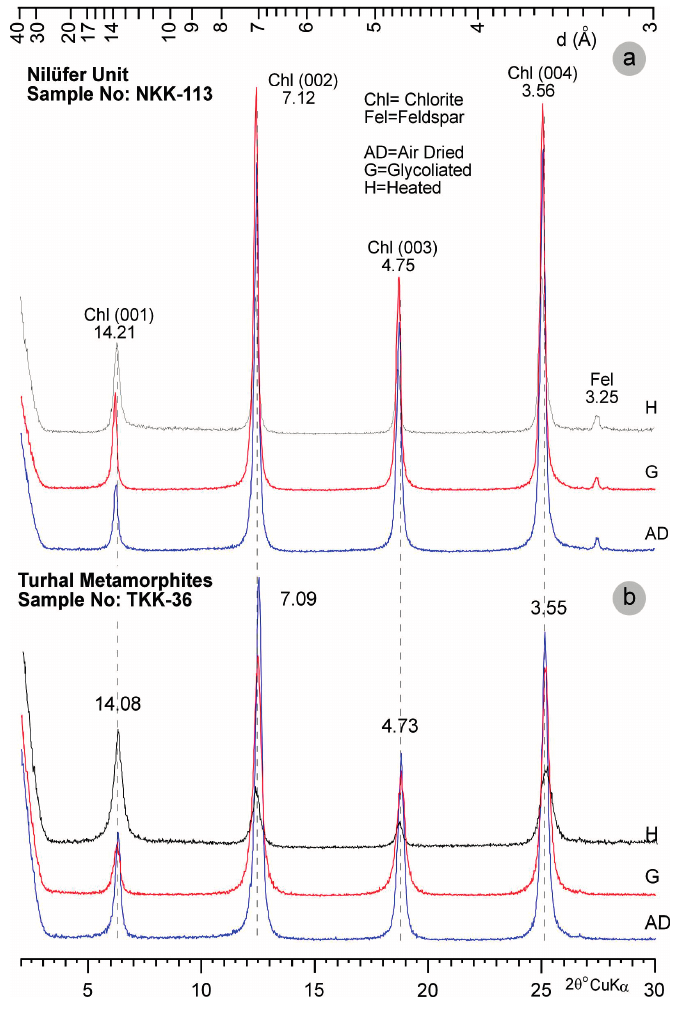
Figure 5. Oriented X-ray diffraction (XRD) patterns of chlorite minerals in the units of Lower Karakaya Complex-Lower Part, ( a ) Slate sample of blueschist facies in the Nilüfer Unit; ( b ) Metatuffite sample of greenschist facies in the Turhal